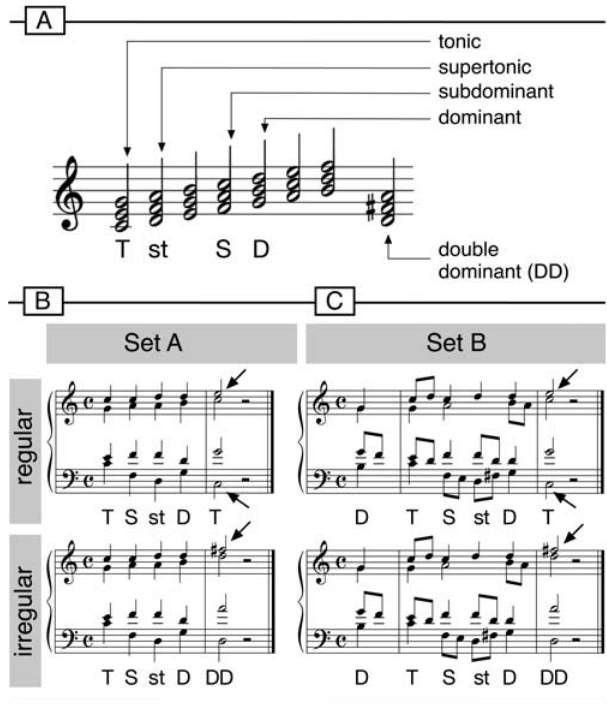
Figure 1. A : Illustration of chord functions. The chord built on the first scale tone is denoted as the tonic, the chord on the second scale tone as the supertonic, on the fourth scale tone as subdominant, and on the fifth scale tone as the dominant. The major chord on the second tone of a scale can be interpreted as the dominant to the dominant, or double dominant (DD). B : Examples of stimulus Set A (‘‘homophonic’’). Chord sequences ended either on a tonic chord (T, regular), or on a double dominant (DD, irregular). Arrows indicate pitches that were not contained in the preceding chords. C : Examples of stimulus Set B (‘‘polyphonic’’). As in Set A, chord sequences ended either on a tonic chord (T, regular), or on a double dominant (DD, irregular). Arrows indicate pitches that were not contained in the preceding chords. In the experiment, sequences from all twelve major keys were presented in direct succession, the tonal key changed from sequence to sequence, and both regular and irregular sequence endings occurred randomly with equal probability (0.5). Stimulus sets were presented in blocks, counterbalanced across subjects.